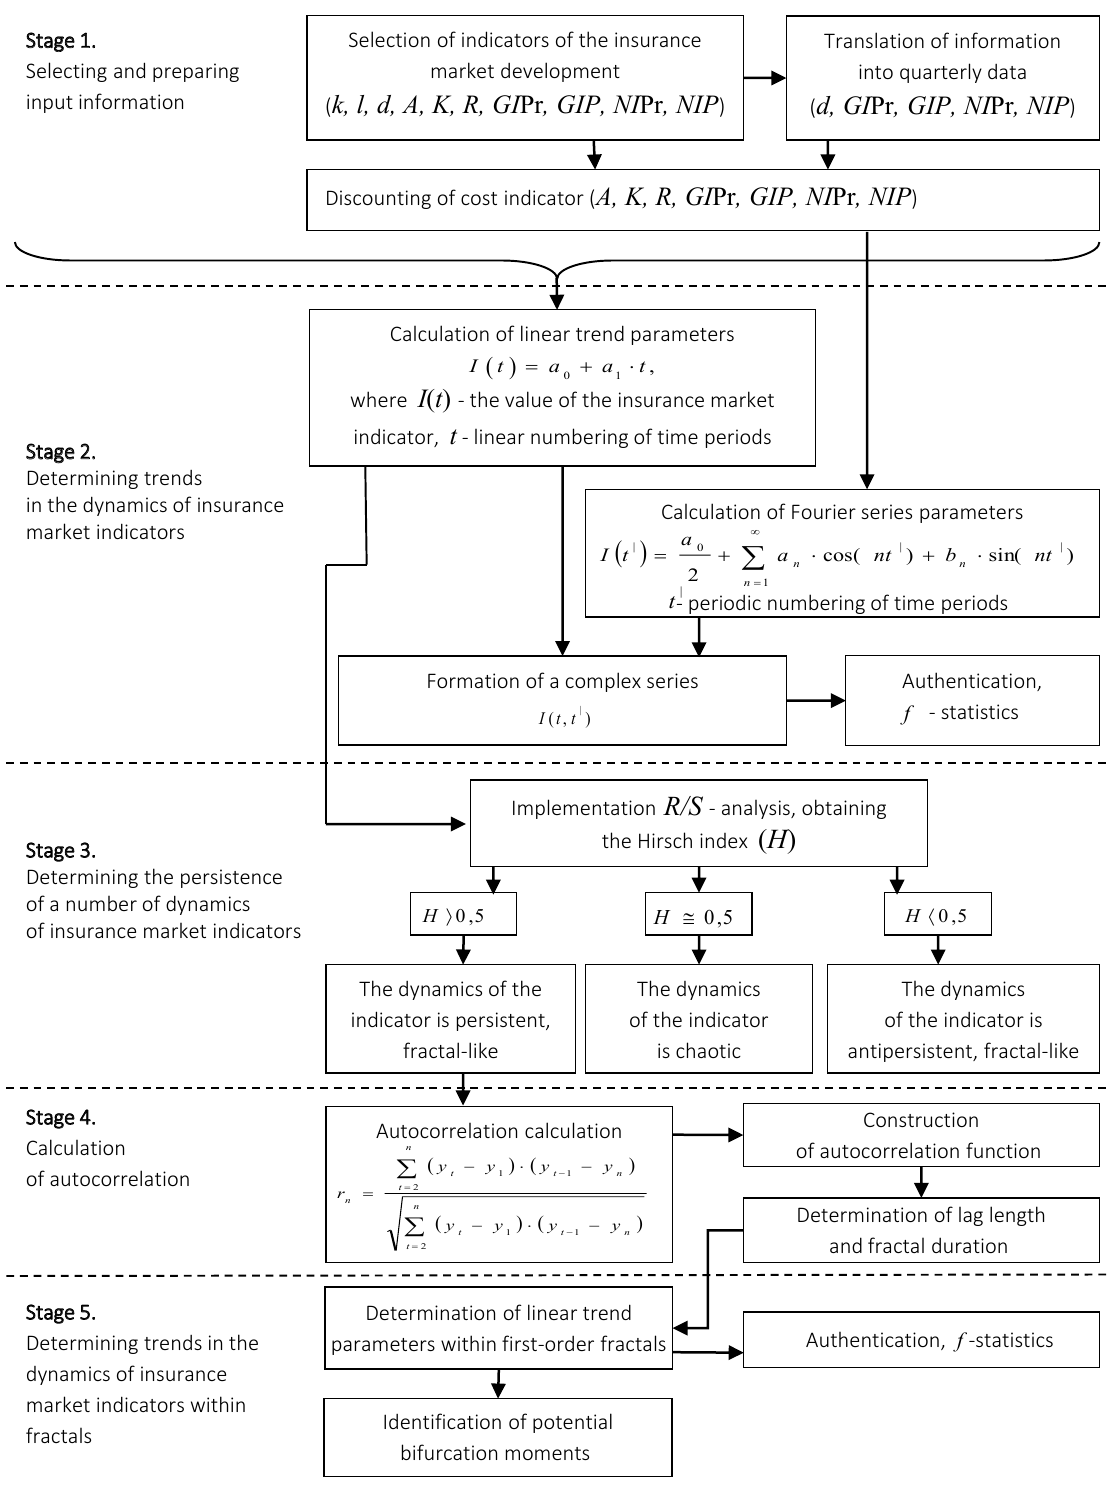
Figure 1. Stages of determining potential moments of bifurcation in the insurance